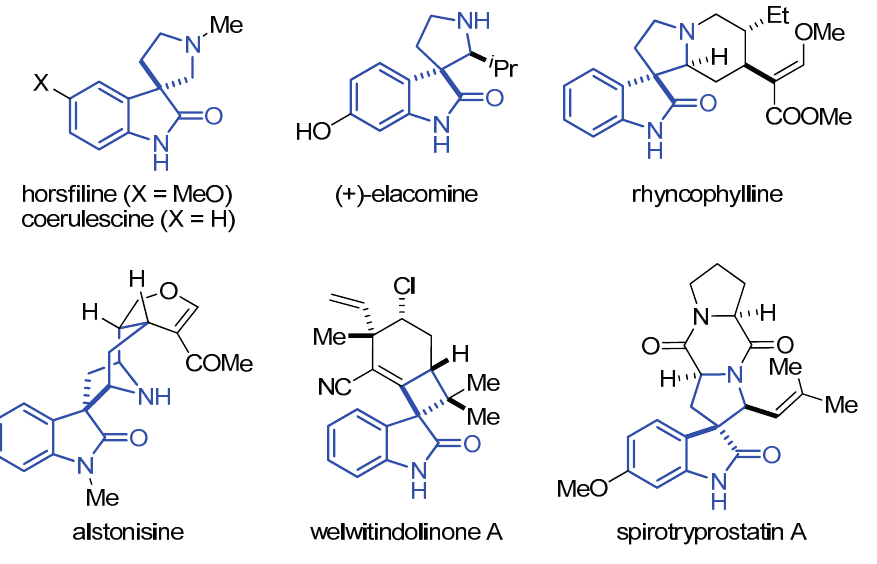
Figure 1. Representative structures of biologically-active